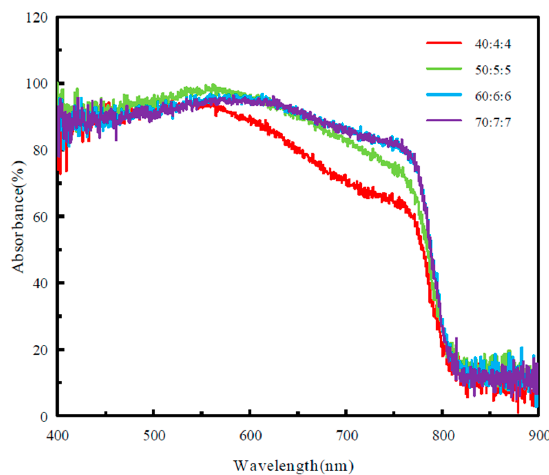
Figure 3. UV–vis absorption spectra of perovskite layers prepared with different concentrations of formamidine methylamine halide precursor solutions.